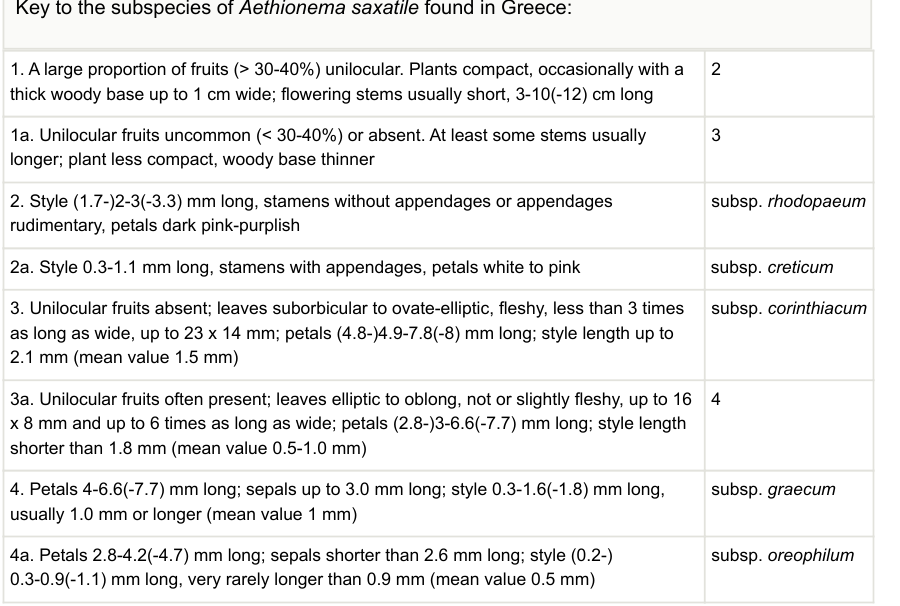
Key to the subspecies of Aethionema saxatile found in